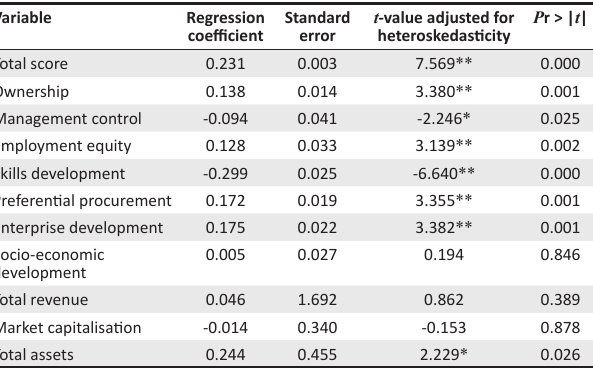
TABLE 10: Cost of equity and total Broad-Based Black Economic Empowerment score and individual elements.